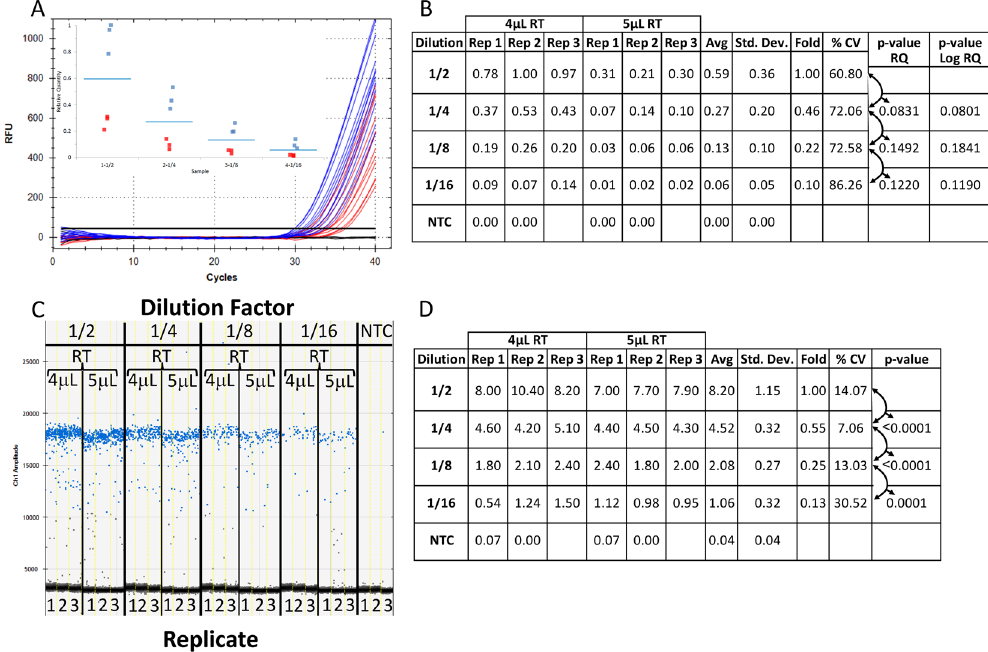
Figure 3. Effect of inconsistent sample contamination for the combined RT-contaminated samples at each DNA dilution for ddPCR and qPCR platforms without normalization. The reproducibility of the data between the combined reactions containing differing amounts of (RT) mix (Fig. 2) was examined for qPCR and ddPCR technologies. Amplification traces ( A ) and box plot (A inset) from the combined qPCR reactions supplemented with 4 uL and 5 uL of RT mix (blue and red traces and graphed points respectively) and tabulated relative fold difference ( Δ Cq) was produced ( B ). The amplitude plot and tabulated absolute concentration data from the combined ddPCR reactions supplemented with 4 uL and 5 uL of RT mix ( C ) and tabulated absolute concentration data ( D ) was generated. NTC: No Template Control; Dilution: Dilution factor of DNA samples; Rep: Replicate number; Avg: Average of the replicates; Std. Dev.: Standard Deviation between the replicates; % CV: % Coefficient of Variance (Std. Dev./Avg * 100); p-value: based on a Student t-test of the Avg between each